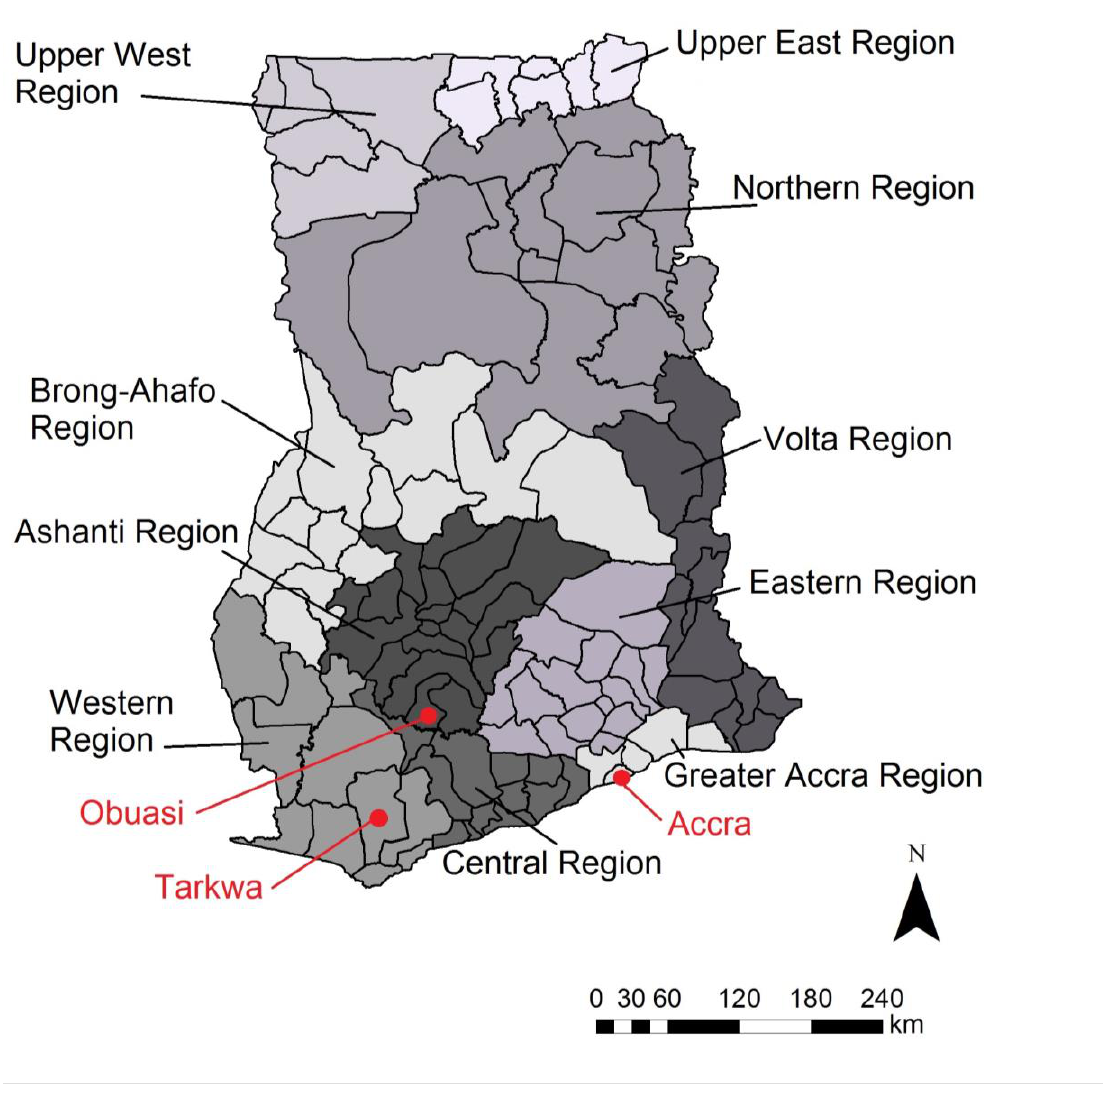
Figure 4. Regional map of Ghana. Key mining areas (Obuasi, Tarkwa) and the capital (Accra) are